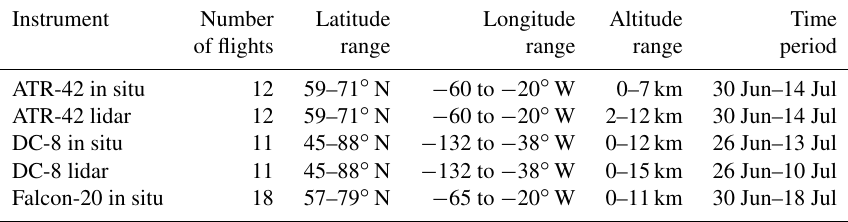
Table 1. Characteristics of the ensemble of ozone measurements made with airborne instruments during summer 2008. Instrument Number Latitude Longitude Altitude Time of flights range range range ATR-42 in situ